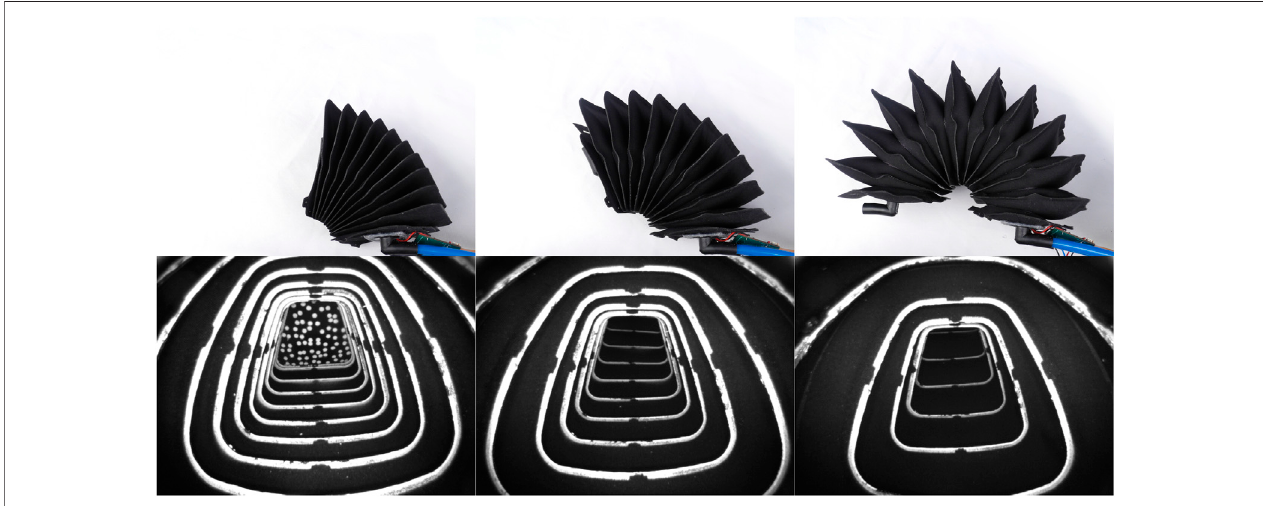
FIGURE 5 | The picture shows a single actuator in fl ated to different expansions and the corresponding image from the internal camera. The number of cushion rings visible to the internal camera decreases as the actuator expands. The light intensity is set such that the white pattern is visible over the full range of the actuator